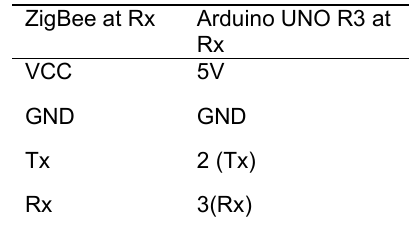
Table 4. Pin connection of ZigBee with Arduino UNO R3 at the receiving side.